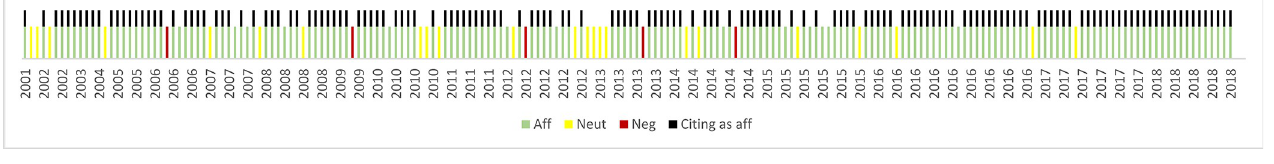
Fig 3. Reception of Wickstro¨m and Bendix 2000.